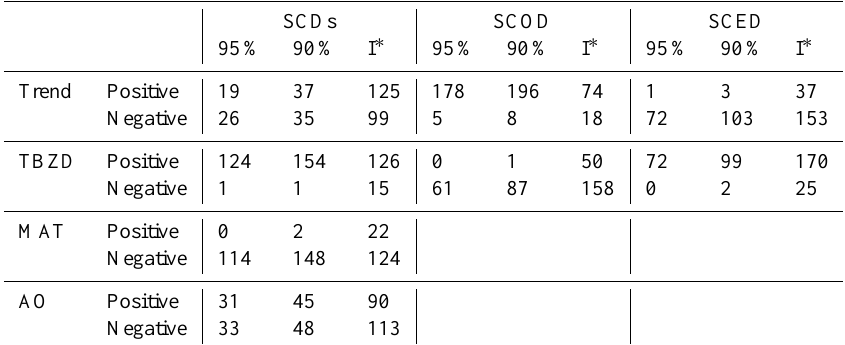
Table 4. Significance of trends according to the Mann–Kendall test of SCDs, SCOD, and SCED, significance of relationships among SCDs, SCOD, SCED, respectively, with TBZD, significance of relationship between SCDs and MAT, and significance of relationship between SCDs and AO (296 stations in total). All of them have two significance levels, 90 and 95%. SCDs SCOD